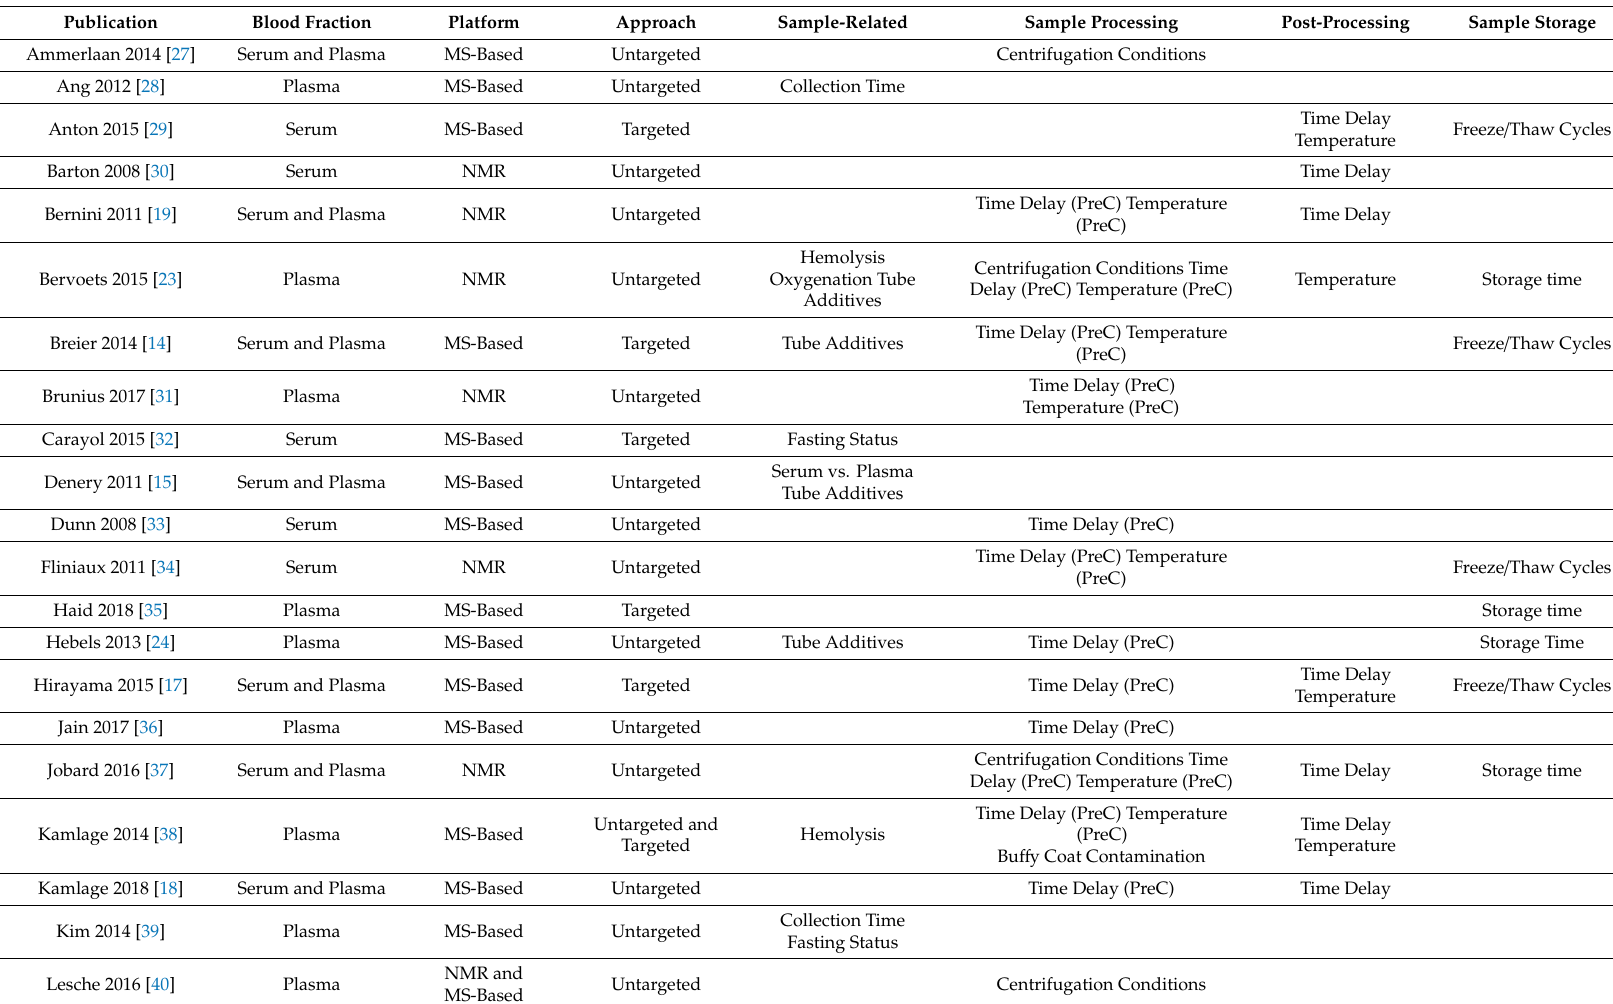
Table 1. Studies of pre-analytical factors that influence metabolomic studies conducted with